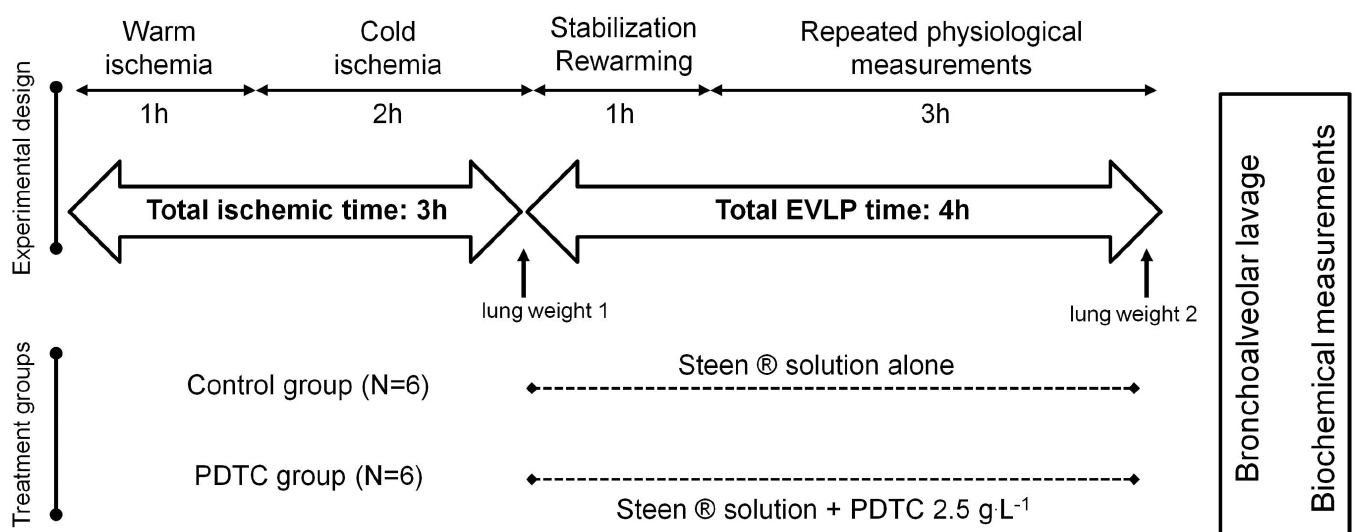
Fig 1. Experimental protocol. Rats were sacrificedby exsanguination and perfusioncannulae were insertedinto the pulmonary artery and the left atrium. The chest was left open for one hour at room temperature (warm ischemictime), with the lungs deflated. The lungs were then flushedwith cold Perfadex ® solution, inflated(5ml (cid:1) kg -1 , FiO 2 0.5), and kept 2 hours in 4˚C Perfadex ® (cold ischemic time). The heart-lungblocks were then weighted(lung weight 1) mounted into a rat EVLP system, and perfusedfor a total of 4 hours, either with Steen ® solution alone (Controlgroup, CTRL, N = 6) or with Steen ® solution supplemented with pyrrolidinedithiocarbamate ammonium(PDTC, C 5 H 9 NS 2 -NH 3 ), at a concentration of 2.5g (cid:1) L -1 (PDTC group, N = 6). At the end of EVLP protocol, the heart-lungblocks were once again weighted(lung weight 2), a bronchoalveolar lavagewas performed through the tracheal cannula, and the left lung was frozen for further